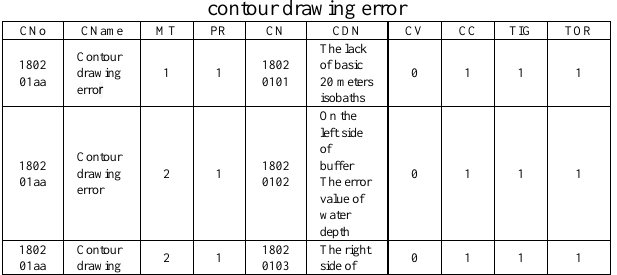
table3-3 Derivation of quality inspection conclusion rules of contour drawing error